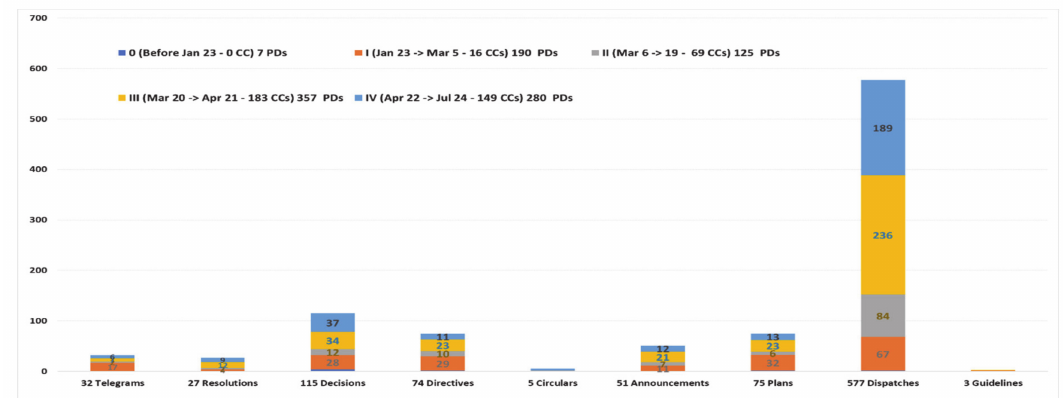
Figure 6. A total of 959 COVID-19 documents classified by policy communication types (as of 24 July 2020). Analyzing the PD types used by various agencies, dispatches were again the most widely used; 24/33 agencies chose to make their policies known in this way, followed by decisions (14/33), telegrams (12/33), directives (10/33), and announcements (7/33). The lowest ranks belonged to circulars and guidelines, with each used only by two agencies (see Figure 7 and Figure S7).